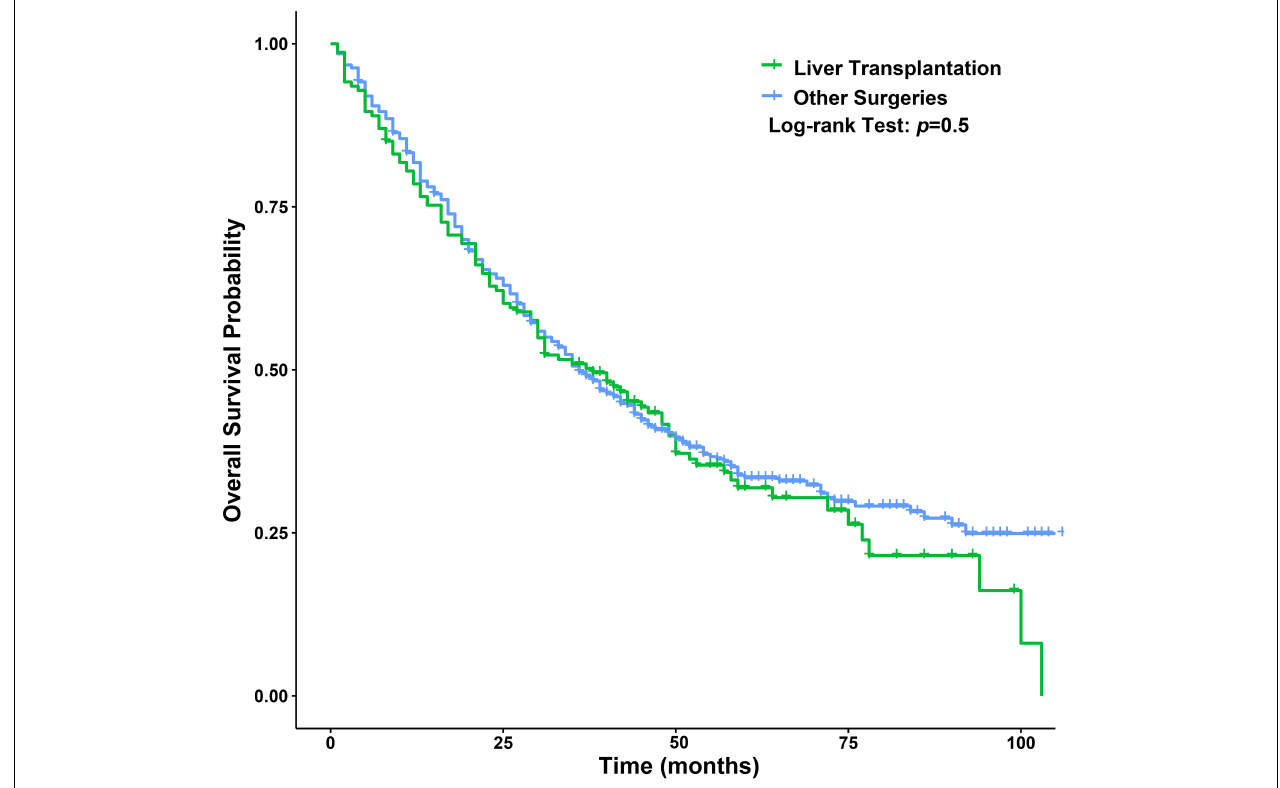
FIGURE 12 | Survival curves between LT and other operations